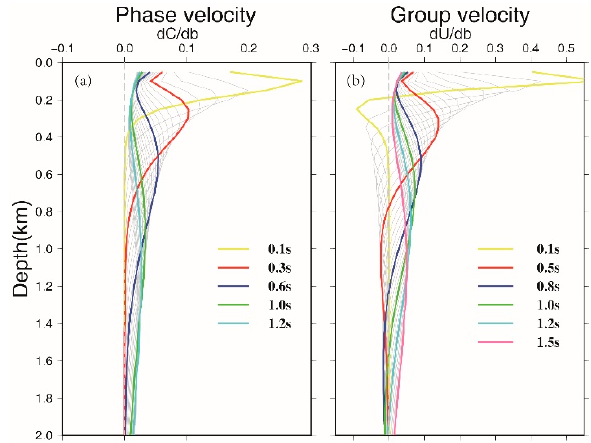
Figure 5. Rayleigh wave depth sensitivity kernels at different periods. ( a ) The sensitivity kernels of the phase velocity. ( b ) The sensitivity kernels of the group velocity. Gray curves show the kernels with 0.1 s increments in between the labeled periods.